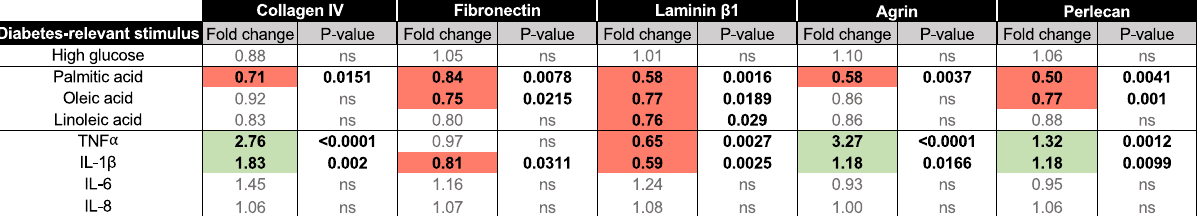
Table 3. Diabetes-relevant stimuli cause significant effects in ECM expression by hRP. All statistical comparisons used t-tests between the DRS-treated group and its respective vehicle, except for the case where normal glucose, l-glucose (osmotic control), and high glucose were compared. In that case ANOVA with Tukey post-hoc was used. For simplicity, only l-glucose vs high glucose is reported here. Expression data are reported as fold induction over vehicle. Red cells highlight statistically significant decreases in expression; green cells highlight statistically significant increases in